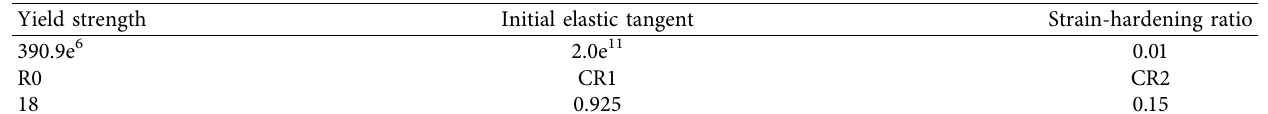
Table 7: Parameter values of rebar used in FE modelling.